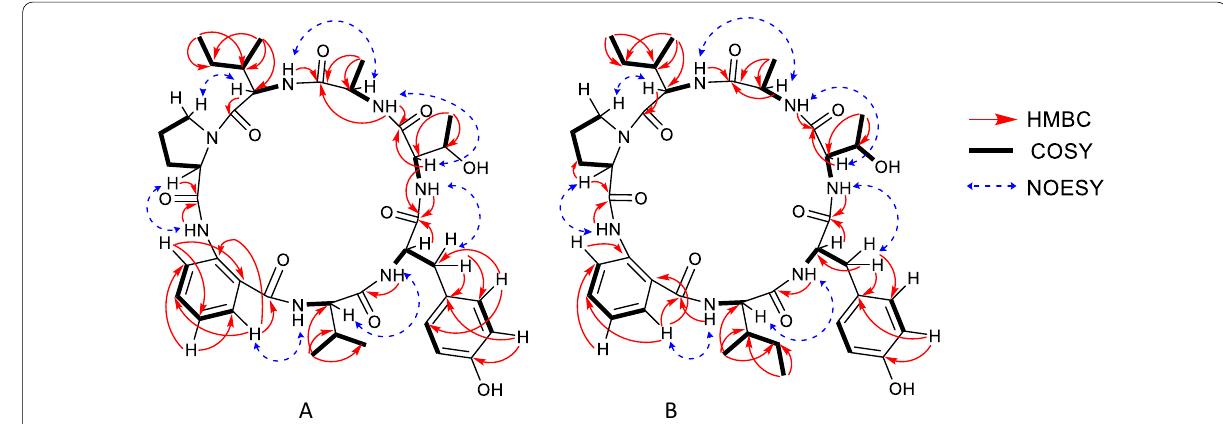
Fig. 2 Relevant correlations observed in 2D NMR experiments. A is cadophorin A and B is cadophorin B